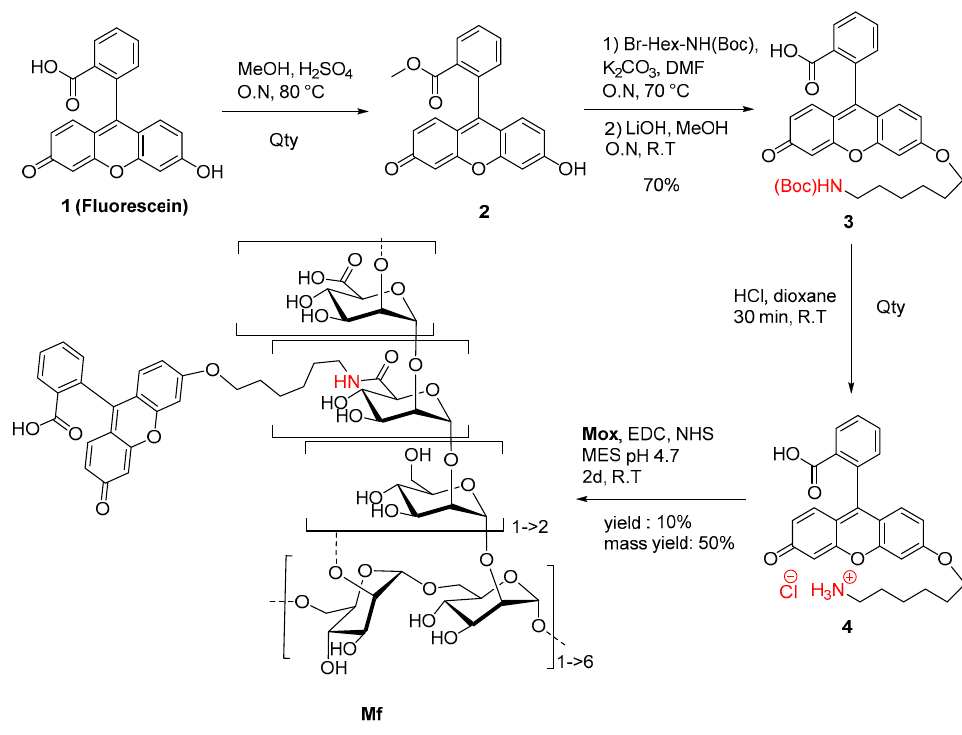
Figure 5. Synthetic route to Mf .